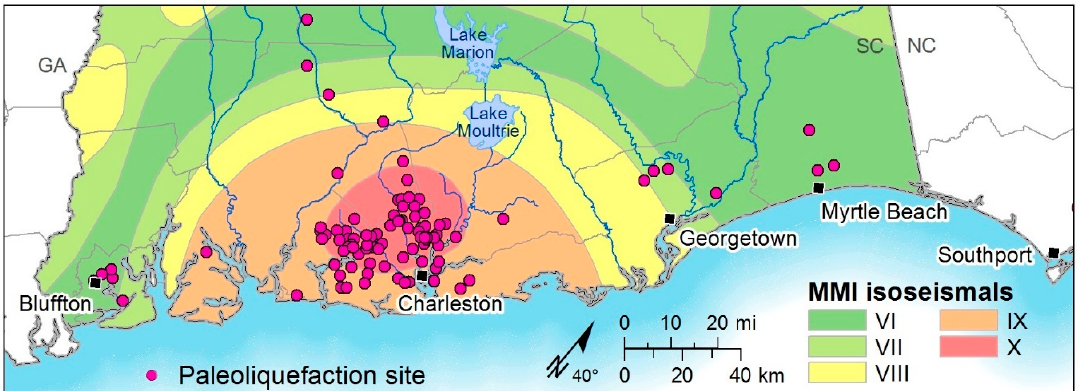
Figure 24. Map of the Charleston seismic zone showing distribution of paleoliquefaction features in the Central and Eastern US Seismic Source Characterization for Nuclear Facilities (CEUS SSC) Project database (from Reference [35]) and modified Mercalli intensity (MMI) isoseismals from the AD 1886 earthquake [207].